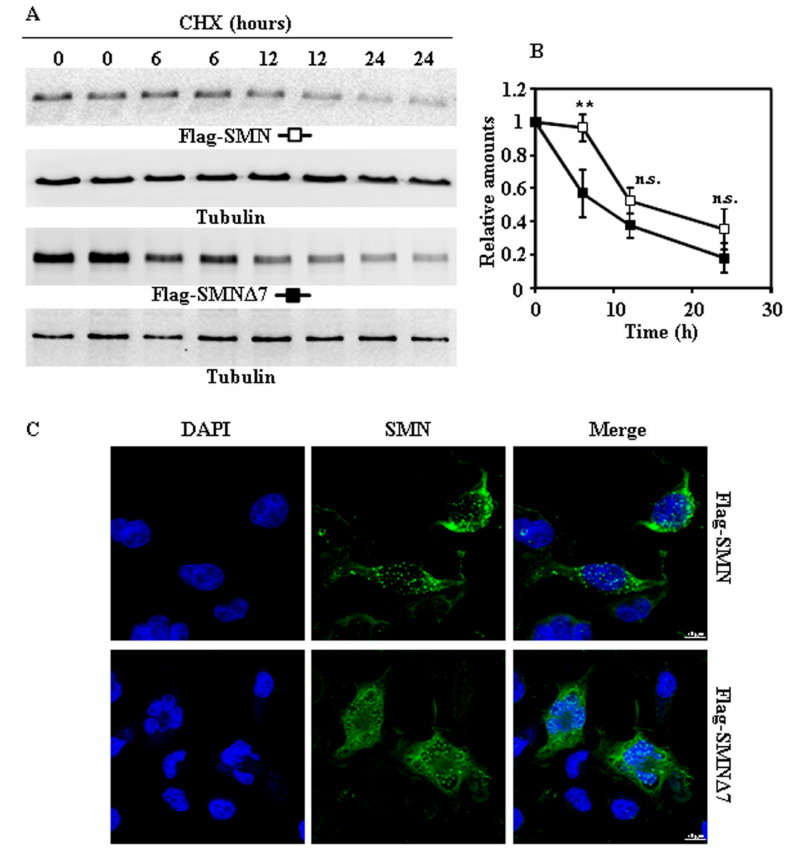
Figure 2. Degradation and subcellular localization of ectopically expressed Flag SMN and Flag-SMN ∆ 7 in HeLa cells. ( A ) HeLa cells were transiently transfected with SMN or SMN ∆ 7 tagged at the N-terminus with Flag and treated with CHX for the indicated times. Total cell lysates were analyzed by Western and immunoblot with anti-Flag specific antibodies; technical replicates are shown for each time point. Anti-tubulin antibodies were used as total protein loading control. ( B ) Graph shows the quantification of the proteins analyzed. ( C ) Confocal fluorescence localization of Flag-SMN or Flag-SMN ∆ 7 in transfected HeLa cells growing under basal conditions, analyzed by indirect immunofluorescence with anti-Flag specific antibodies (green channel) and counterstained for nuclei with DAPI (blue channel). Bars = 10 µ m. Values are expressed as mean ± S.E.M. from three different experiments. Asterisks indicate a statistical significant difference between pairs (** p < 0.01, Student’s t -test). n.s., not